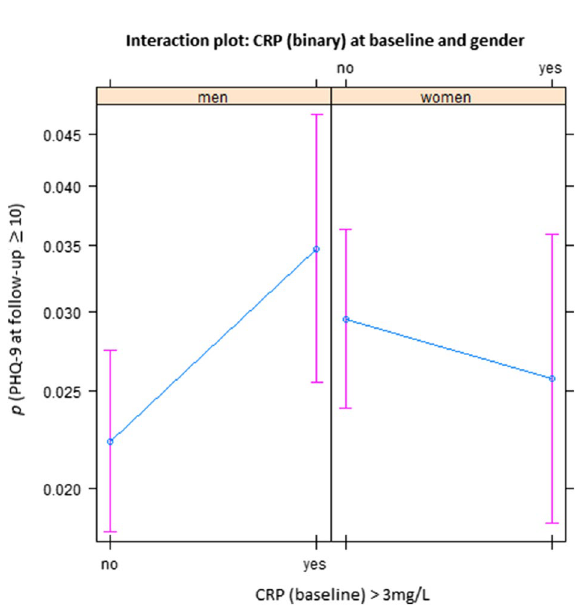
Figure 2. Association with baseline CRP levels and depression symptoms at follow-up in men and women. We observed gender differences regarding the association of elevated levels of CRP at baseline with new onset of depression at follow-up: in men, elevated CRP at baseline was associated with higher PHQ-9 scores at follow-up; whereas in women, no clear effect of baseline CRP on PHQ-9 at follow-up was apparent. The plot results show the probability ( p ) and 95% confidence intervals of depression (PHQ-9 ≥ 10) estimated based on the regression model of the total sample (reported in Table 2), depending on baseline CRP (normal versus elevated) and other predictors held fixed. (Figures were created using R version 3.6.1 https ://www.R-proje